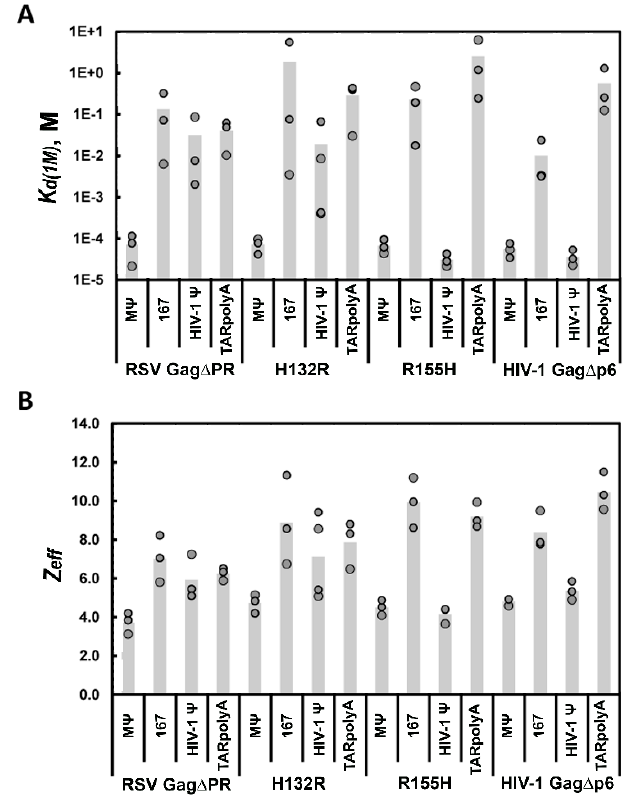
Figure 3. Bar graphs showing K d(1M) values ( A ) and Z eff values ( B ) determined from salt-titration assays with RSV Gag ∆ PR, H132R, R155H, and HIV-1 Gag ∆ p6 with RSV M Ψ , RSV 167, HIV-1 Ψ , and HIV-1 TARpolyA. Values of three or four trials performed in each case are shown with the height of the bar indicating the mean value. Table 2. Binding parameters determined from FA salt ‐ titration assays of wild ‐ type (WT) and chimeric Gag constructs.